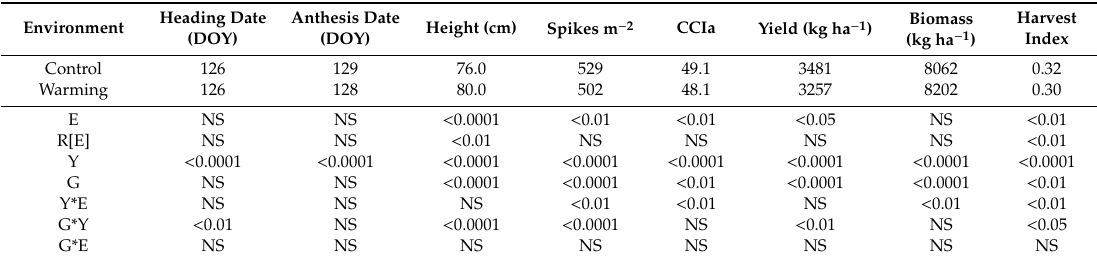
Table 3. Least squares means by environment for agronomic traits † measured on a panel of 36 soft red winter wheat genotypes under ambient and passively warmed conditions, 2015–2016 Lexington, KY. Least squares means were calculated from the combined ANOVA over years. Significance of mean squares shown below least squares